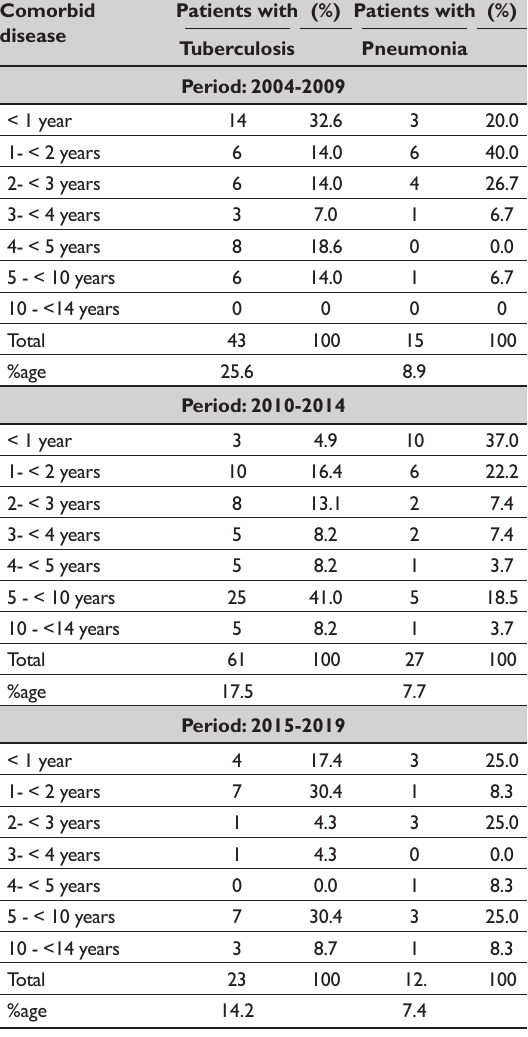
Table 4: The number and proportion (%) of patients with pulmonary tuberculosis (PTB) or pneumonia (PNM) in each age-group at the time of initiation of antiretroviral therapy (ART) during each policy period Comorbid Patients with (%) Patients with disease